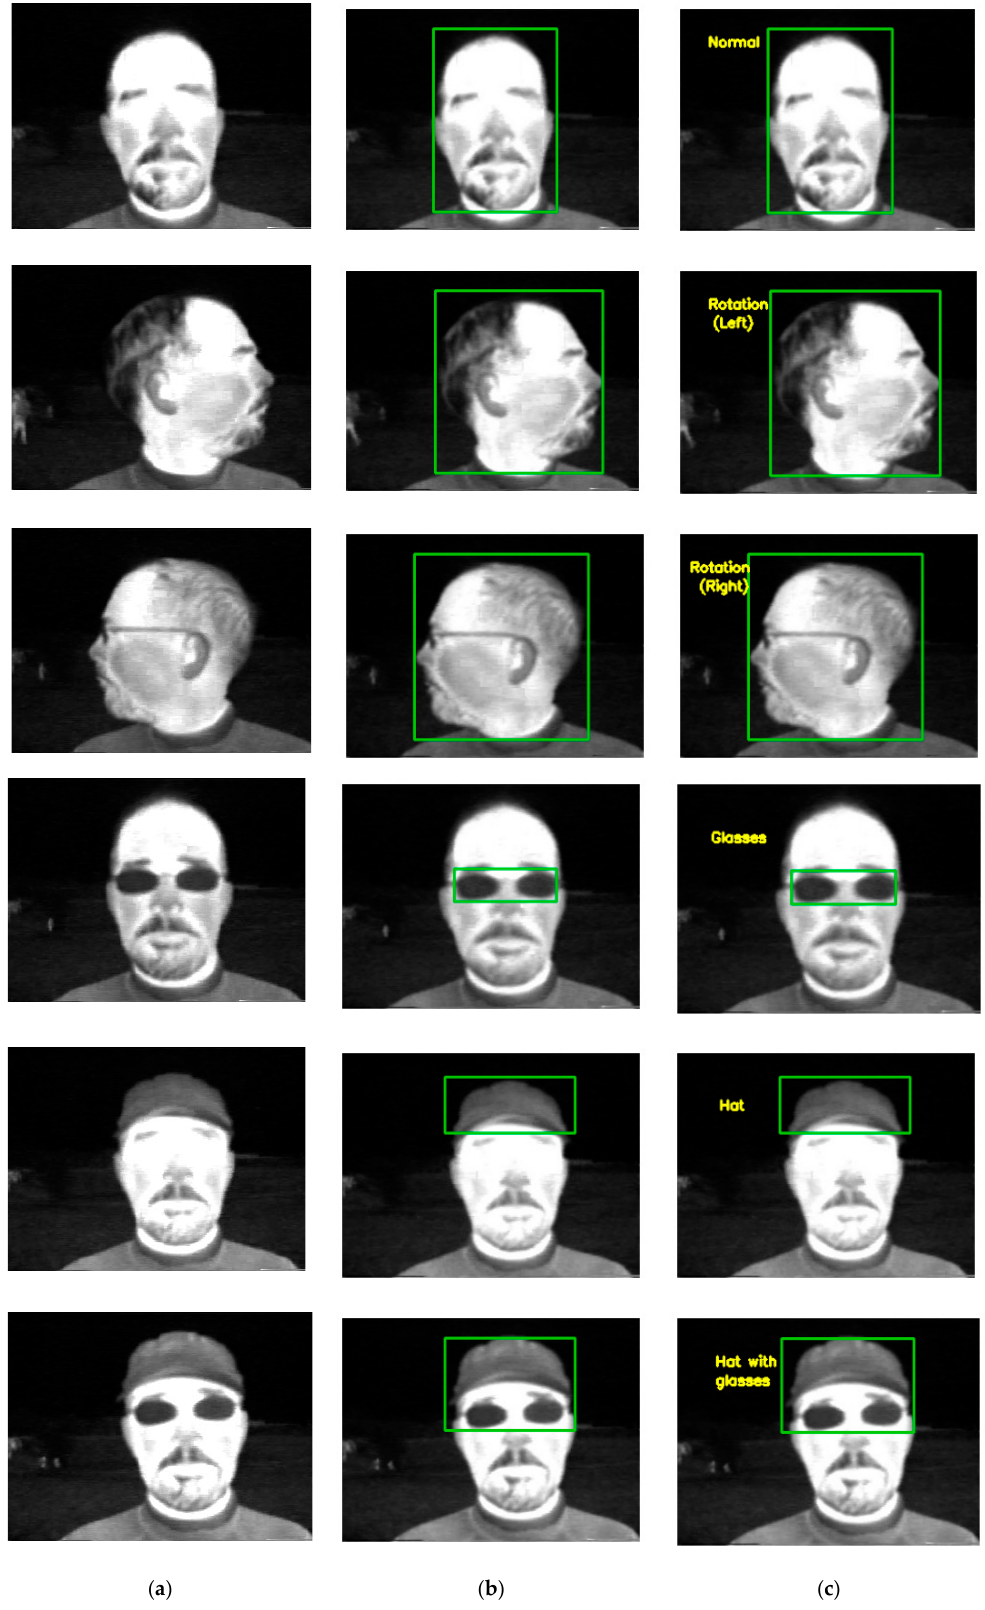
Figure 4. Classification of objects and actions. ( a ) Original Image. ( b ) Objects and Action Detection. ( c ) Classification results. ( c ) Classification